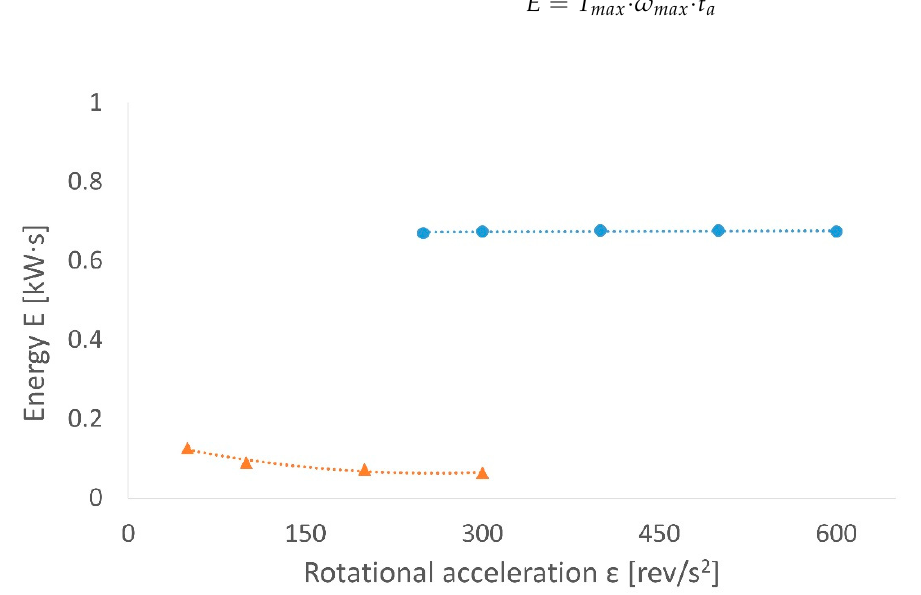
Figure 14. The correlation between the consumed energy in the acceleration phase and the rotational acceleration ε for a constant maximum rotational speed ω for WDU (orange) and perforating head (blue) drives.